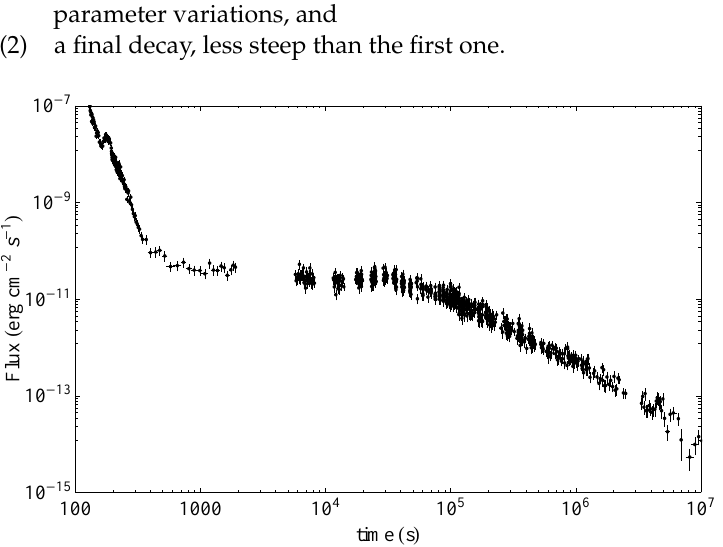
Figure 3. The X-ray afterglow of GRB 060729 with all the three power-law segments and an initial flare clearly